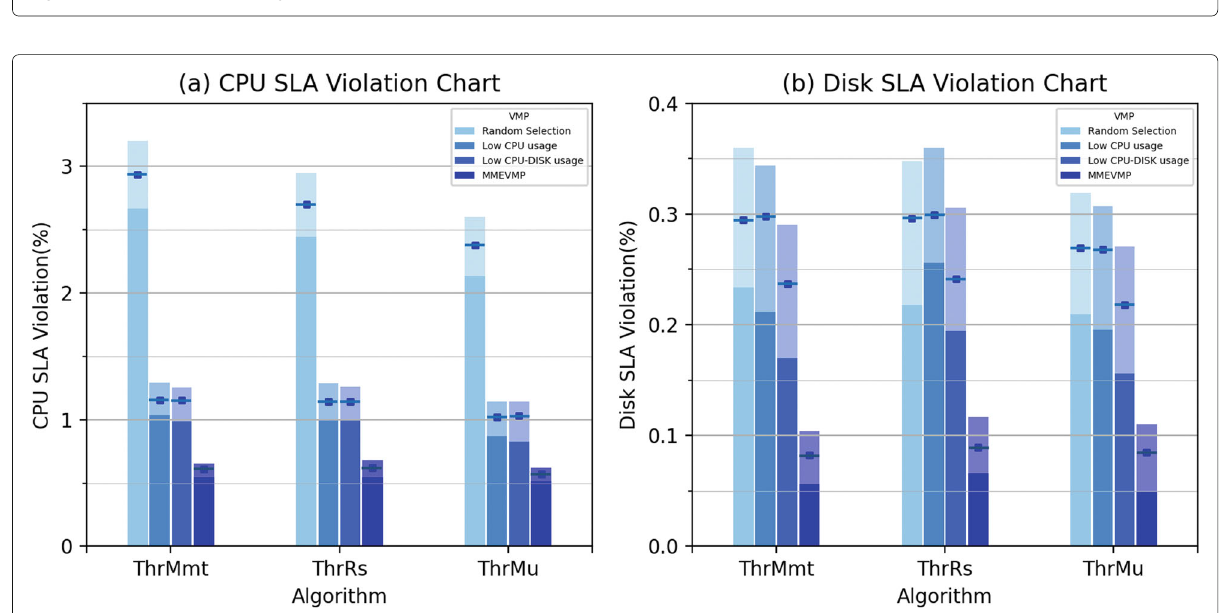
Fig. 9 SLAV Chart CPU SLAV(Left), Disk